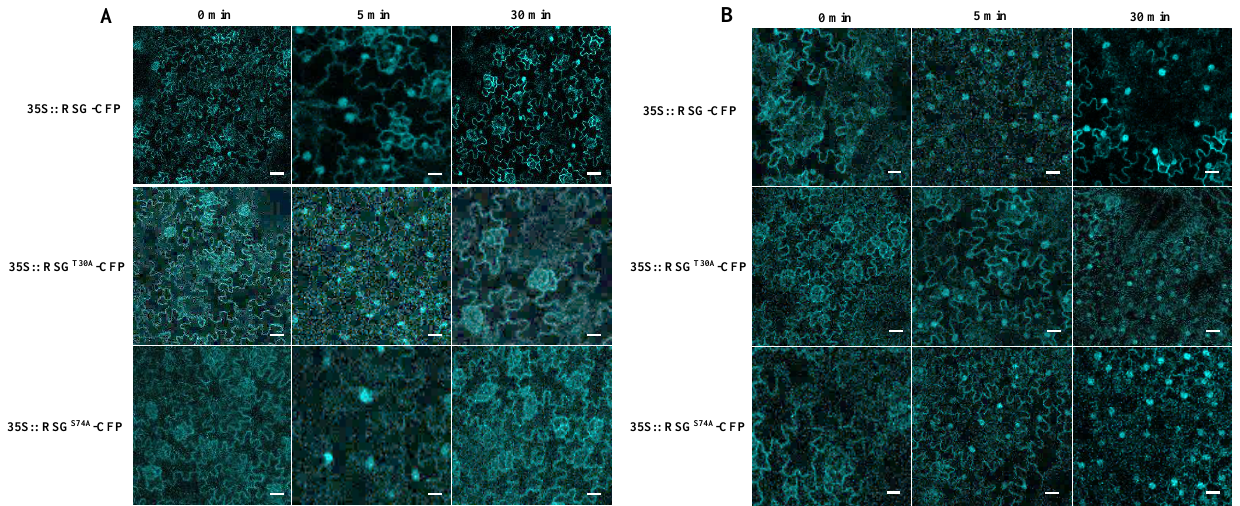
Figure 5. RSG T30A and RSG S74A show durable localization in tobacco nuclear after B. cereus AR156 treatment. ( A ) Observation of transgenic tobacco overexpressed RSG, RSG T30A , or RSG S74A fused with CFP upon treatment of flg22. RSG and indicated mutants tagged with CFP were stably expressed in transgenic N. tabacum and analyzed by confocal microscopy after flg22. ( B ) Observation of transgenic tobacco overexpressed RSG, RSG T30A , or RSG S74A fused with CFP upon treatment of B. cereus AR156 suspension. RSG and indicated mutants tagged with CFP were stably expressed in transgenic N. tabacum and analyzed by confocal microscopy after B. cereus AR156 treatment. CFP signal is in cyan. Images are single confocal sections, representative of images obtained in two independent experiments performed for each protein; for each experiment, three infiltrations were performed on three different leaves, with two images recorded per infiltration. Scale bars = 40 µM.